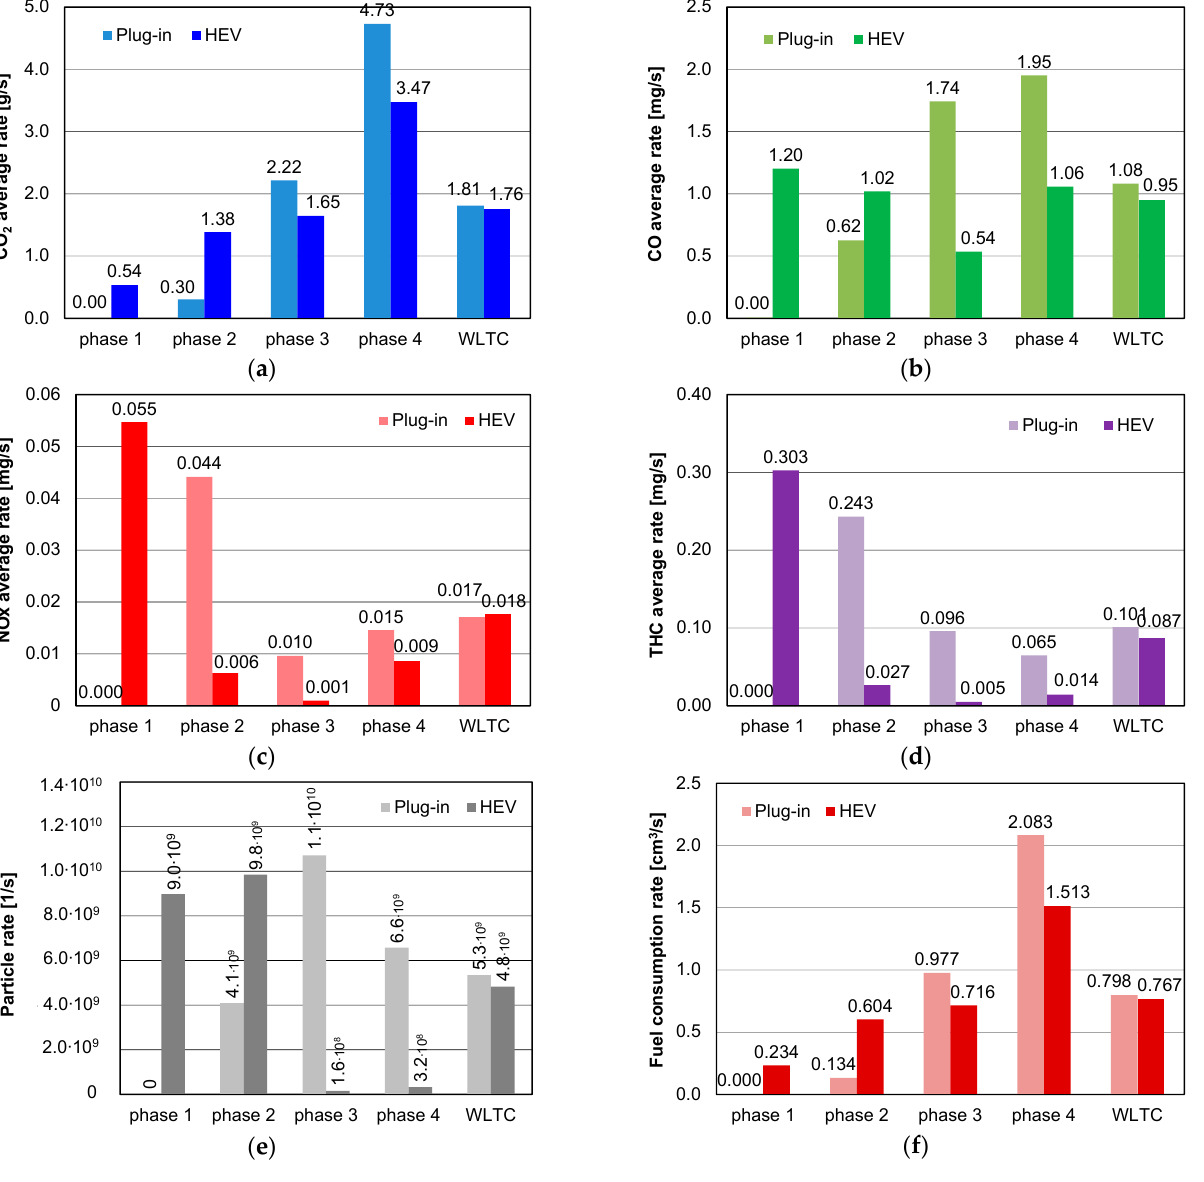
Figure 23. Emission rate of the plug-in and HEV vehicles of individual emissions compounds and fuel consumption: ( a ) carbon dioxide, ( b ) carbon monoxide, ( c ) nitrogen oxides, ( d ) hydrocarbons, ( e ) particle number, and ( f ) fuel consumption.